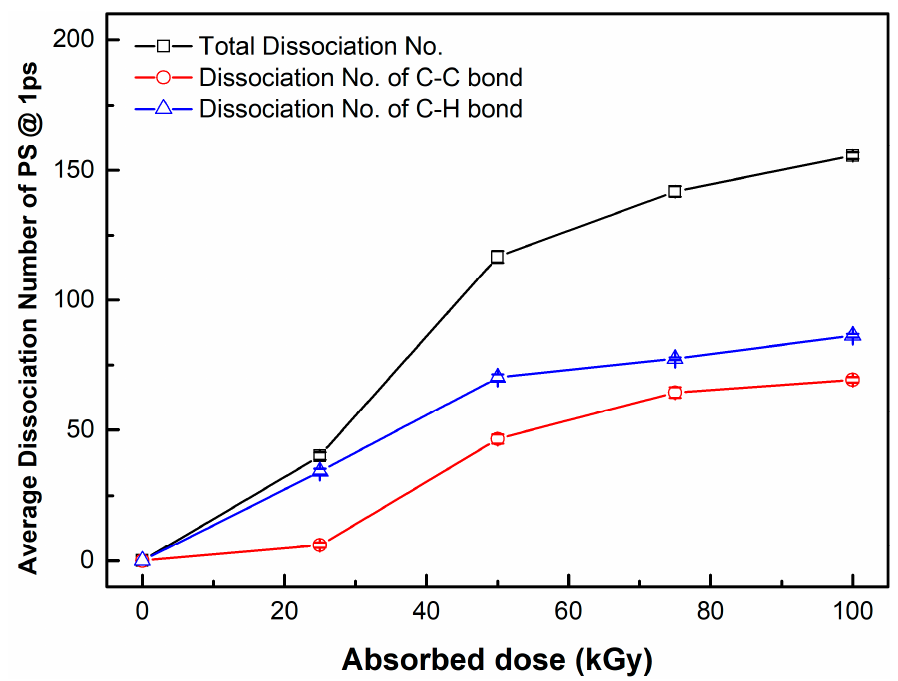
Figure 5. Average dissociation number of each bond in polystyrene at 1 ps.